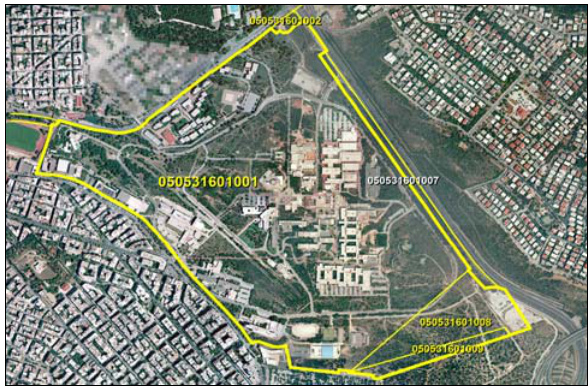
Figure 1. NTUA’s distinct cadastral